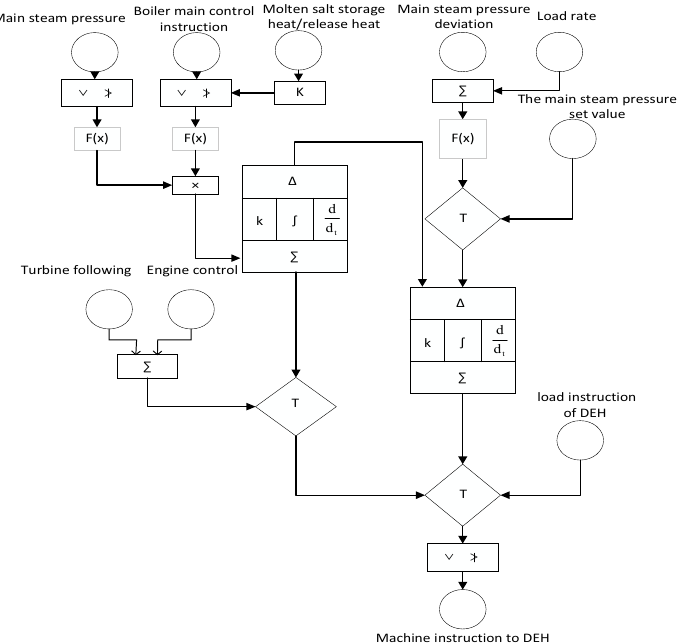
Figure 5. The control representation of the turbine main control and the molten salt storage